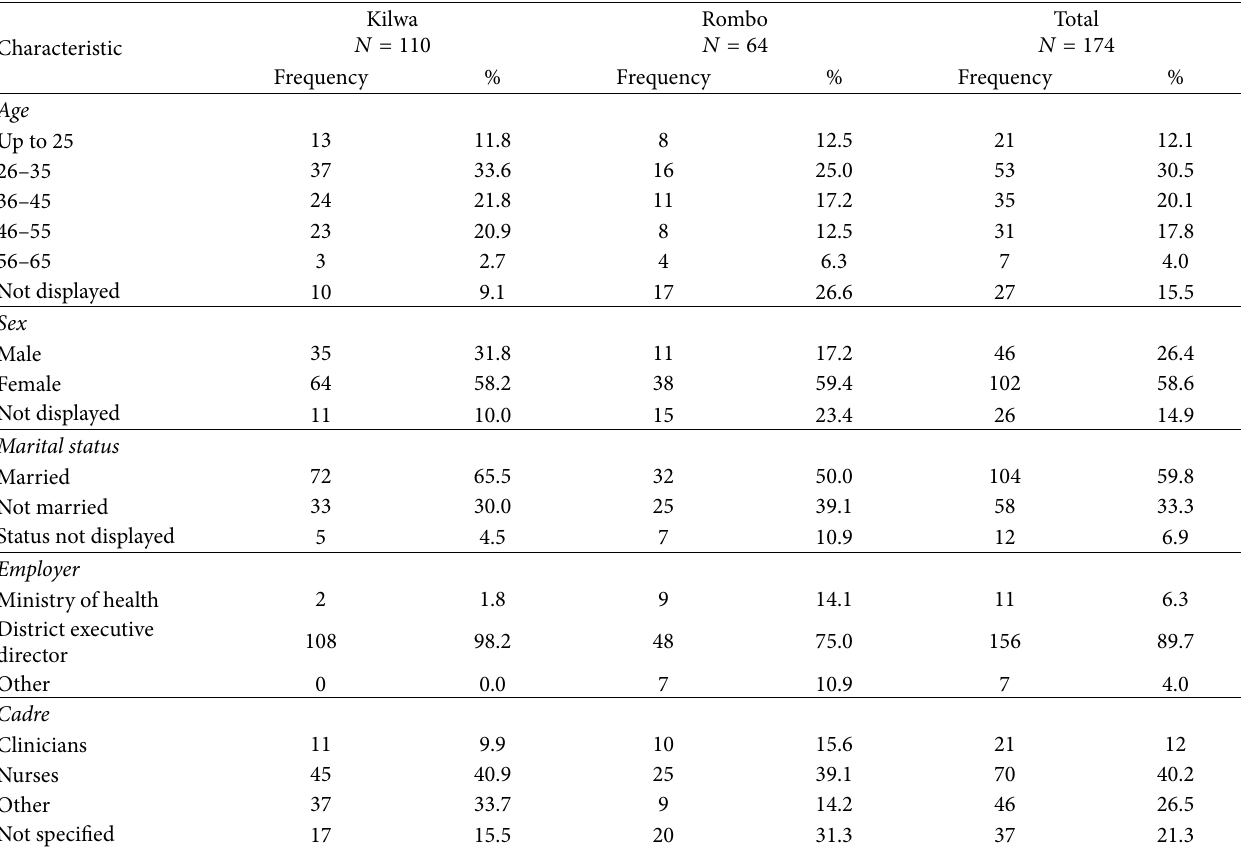
Table 3: Socio-demographic characteristics of health workers responded to the